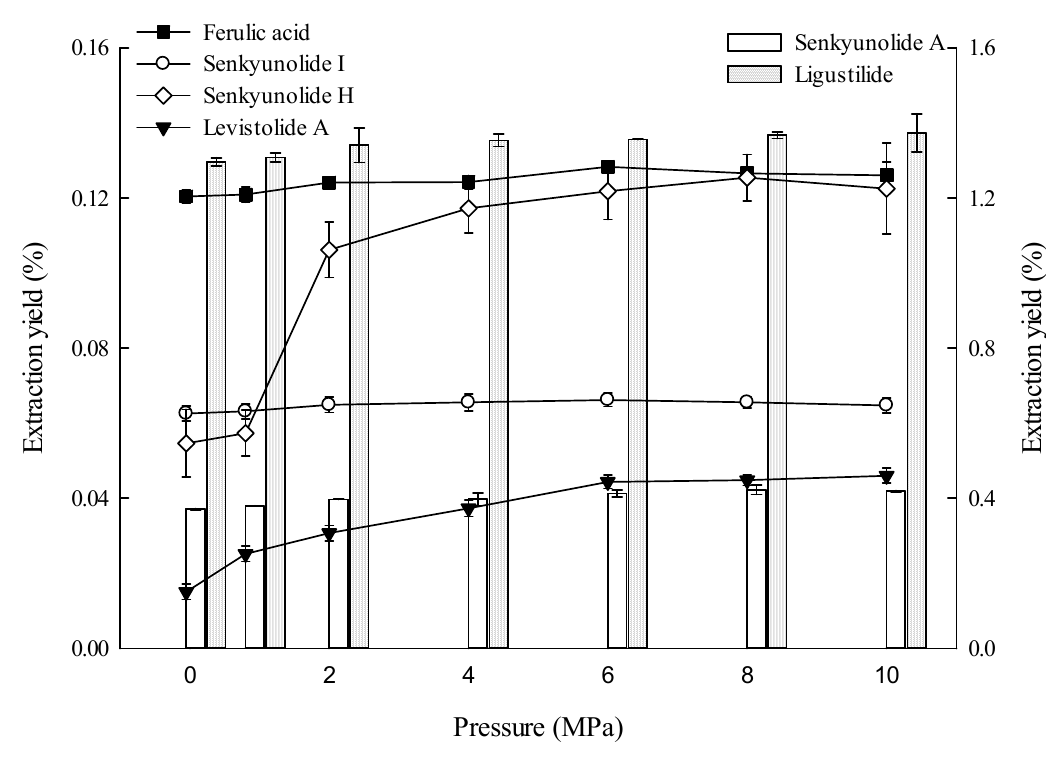
Figure 2. Effects of pressure on extraction yields of the six constituents (the lines and bar graphs are referenced to the left and right axes,